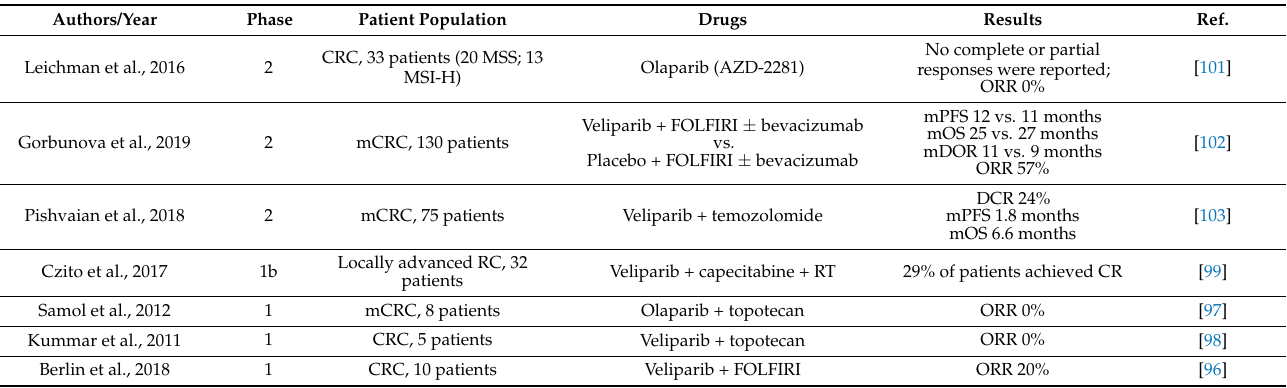
Table 1. Published trials on PARPi in